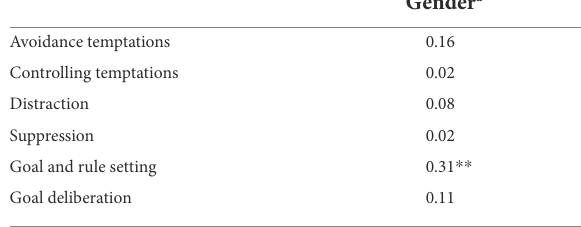
TABLE 3 Results of the latent mean differences tests across genders for the six specific self-regulation